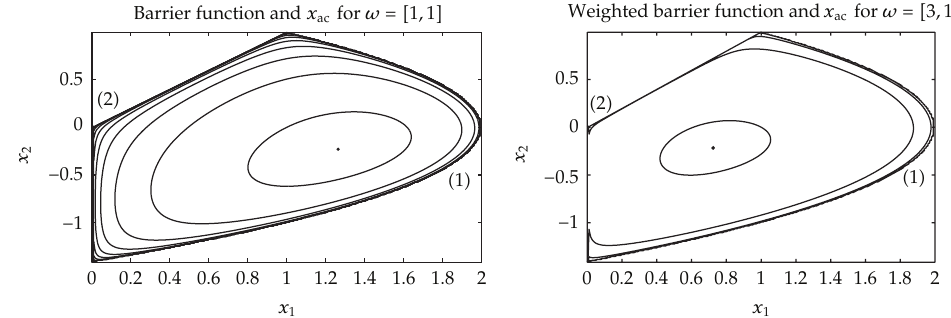
Figure 1: φ ω (cid:2) x (cid:3) contours and x ac (cid:2) ω (cid:3) with various weights ω